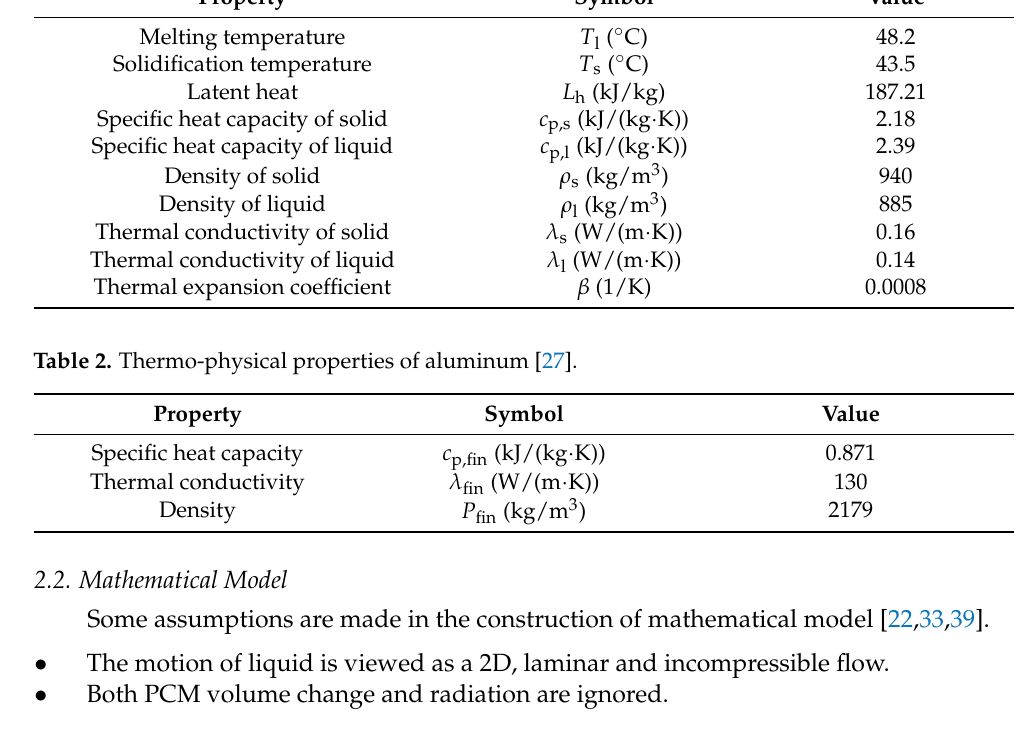
Table 1. Thermo-physical properties lauric acid [27,33,42].